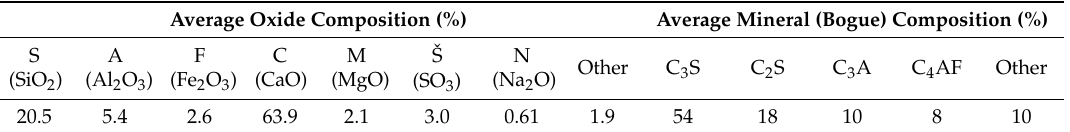
Table 1. Chemical and mineral composition of Type I